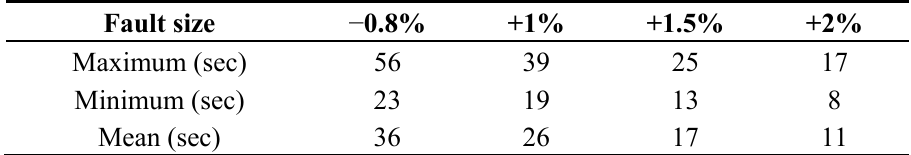
Figure 13. Voltage sensor fault diagnostic results under DST test. ( a ) Generated residual r ; ( b ) Filtered residual r ; ( c ) Residual evaluation result S ( k ) using CUSUM; ( d ) Detected voltage sensor fault. Table 4. Detection time for voltage sensor fault under UDC and DST